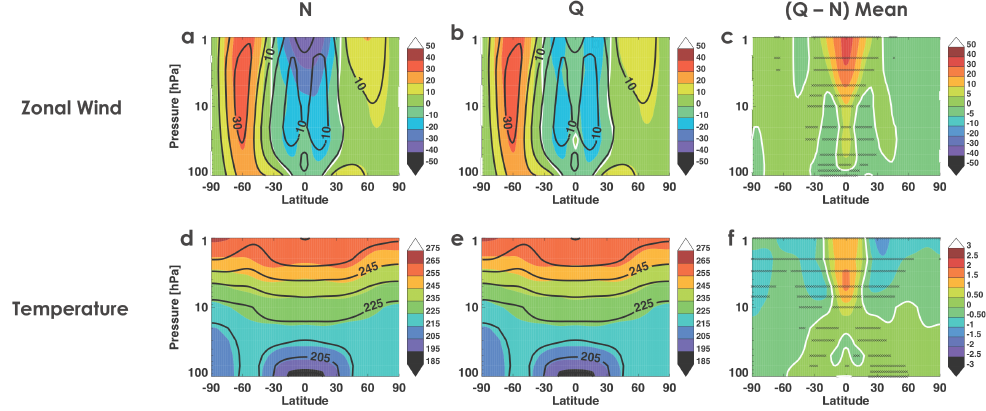
Fig. 3. (a–c) Zonal wind (ms − 1 ) and (d–f) temperature (K), for (a, d) N simulation zonal and annual mean and (b, e) Q simulation zonal and annual mean; black contours indicate MERRA reanalysis mean for 2000–2010. (c, f) Q − N mean differences; white contours indicate zero difference; black Xs indicate changes significant at the 95% level in a two-trailed t test.